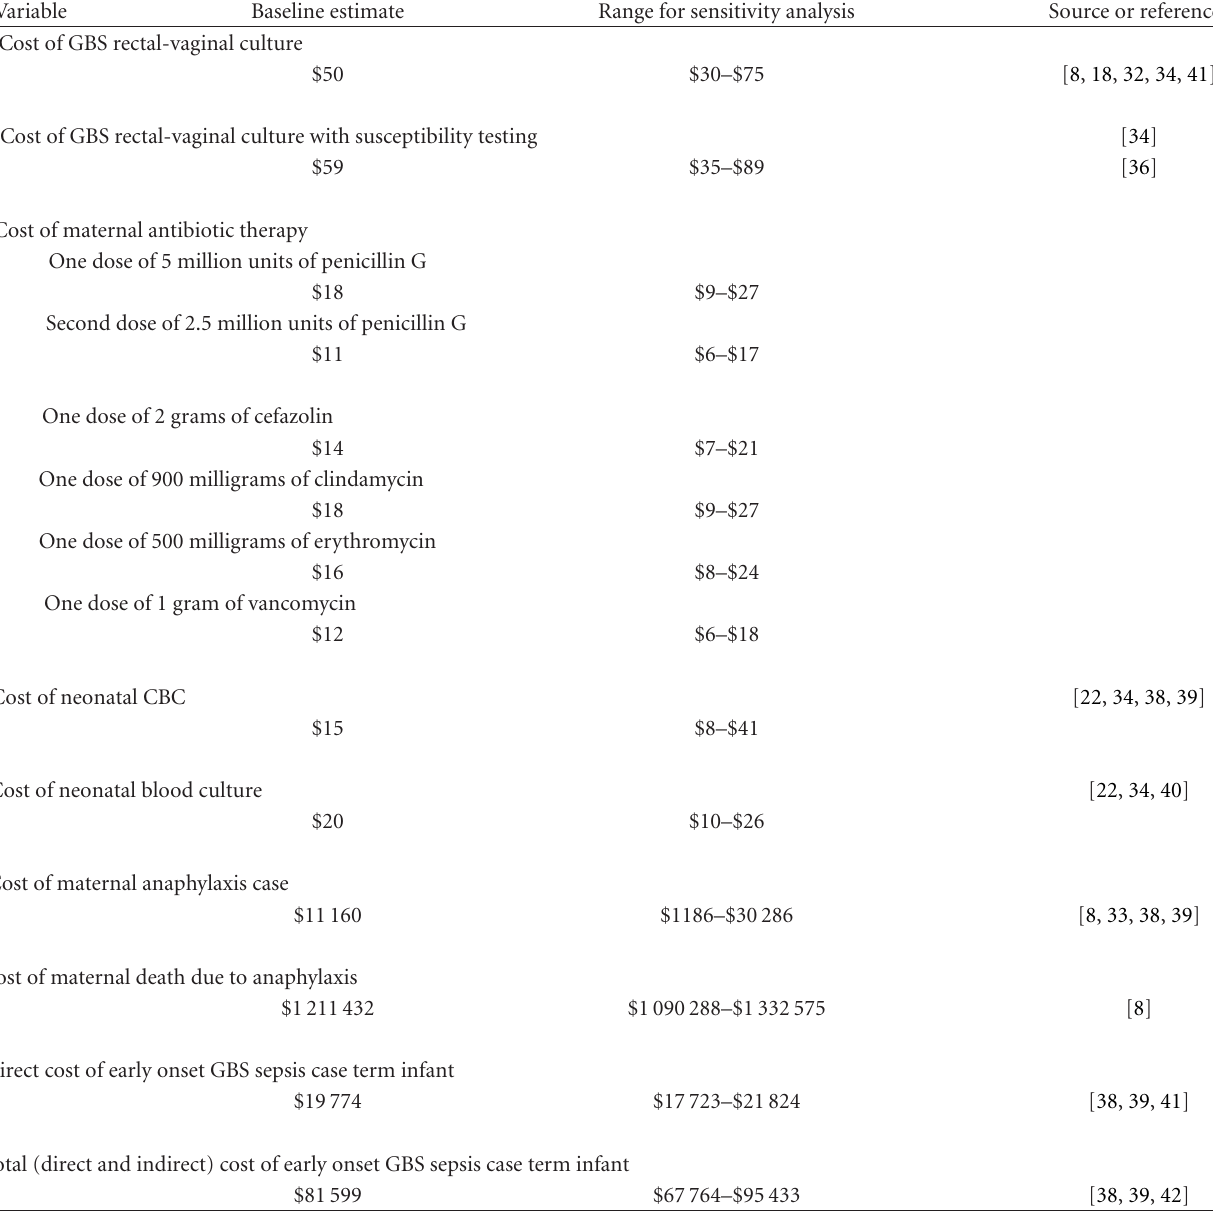
Table 2: Costs (in 2008 USD) included in decision